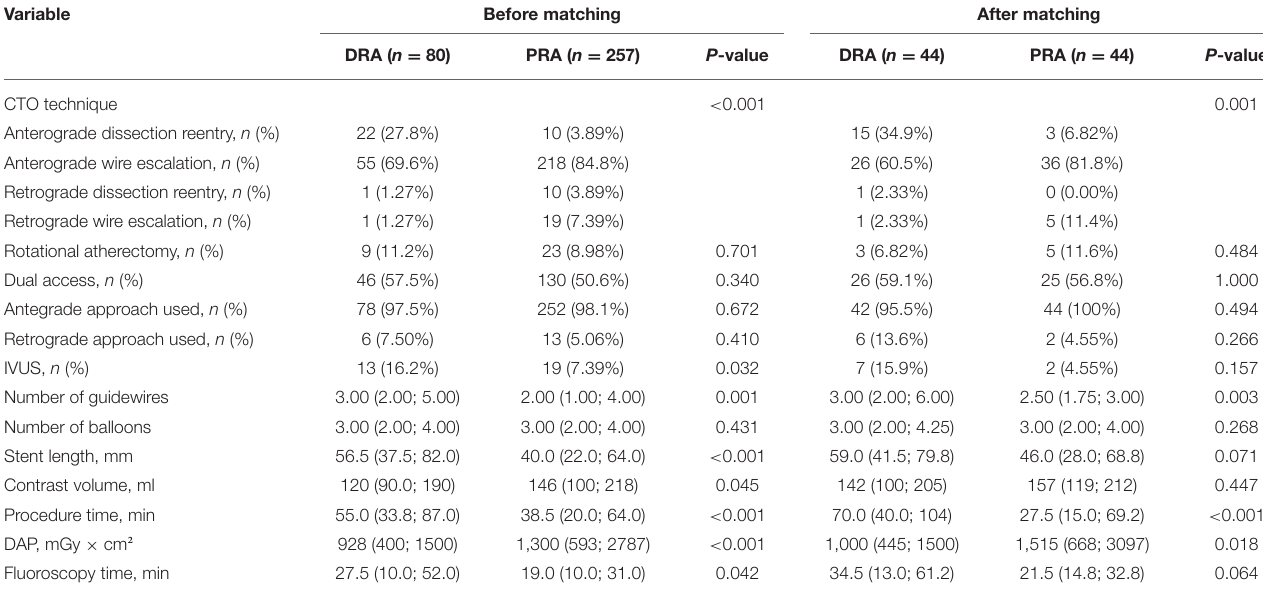
TABLE 2 | Intraprocedural characteristics.